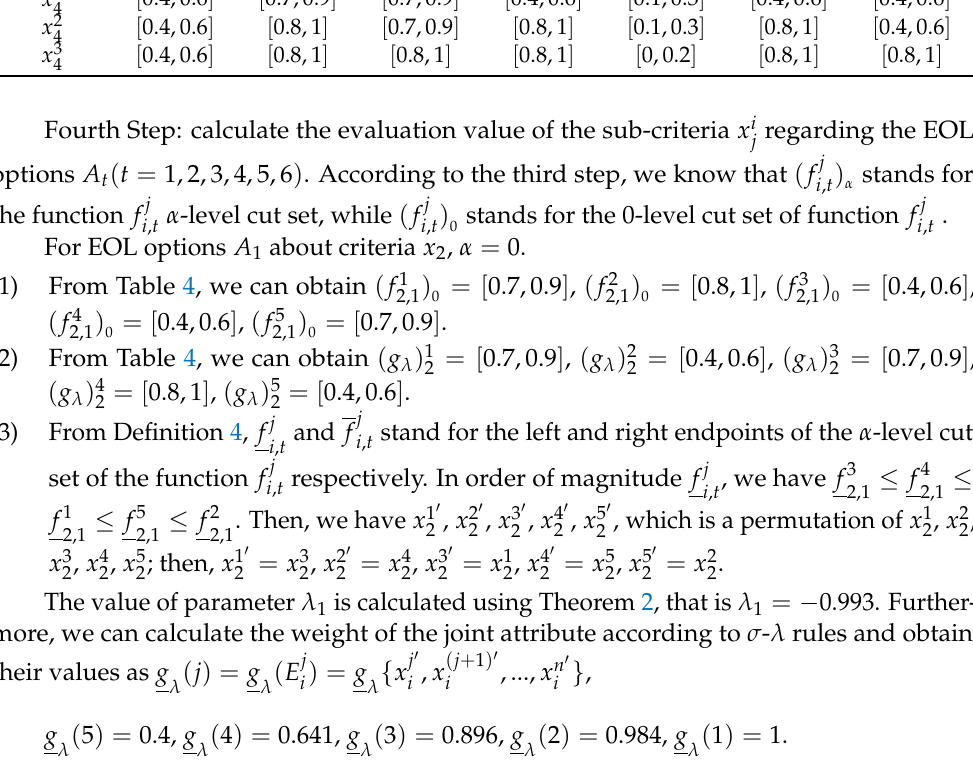
Table 5 lists all measured values and the values of the required parameters λ